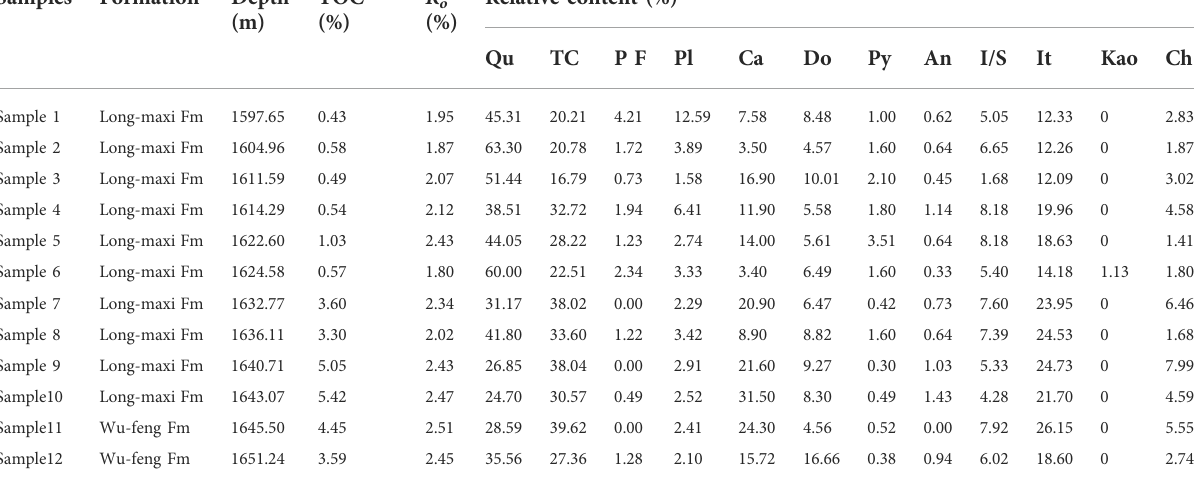
TABLE 1 Geochemical characteristics and mineral composition of shale